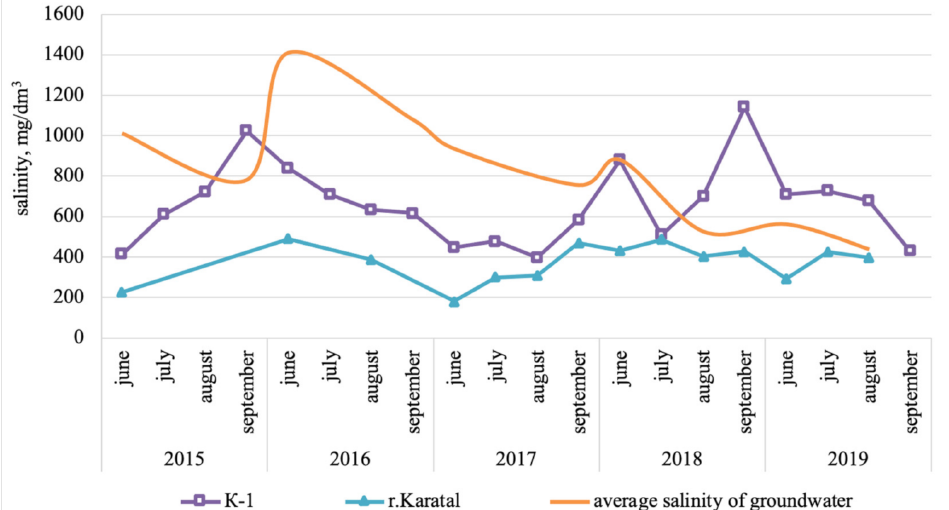
Figure 3. Dynamics of salinity of irrigation and collector-drainage waters and average salinity of GW in the Karatal irrigation massif for 2015–2019, mg/dm 3